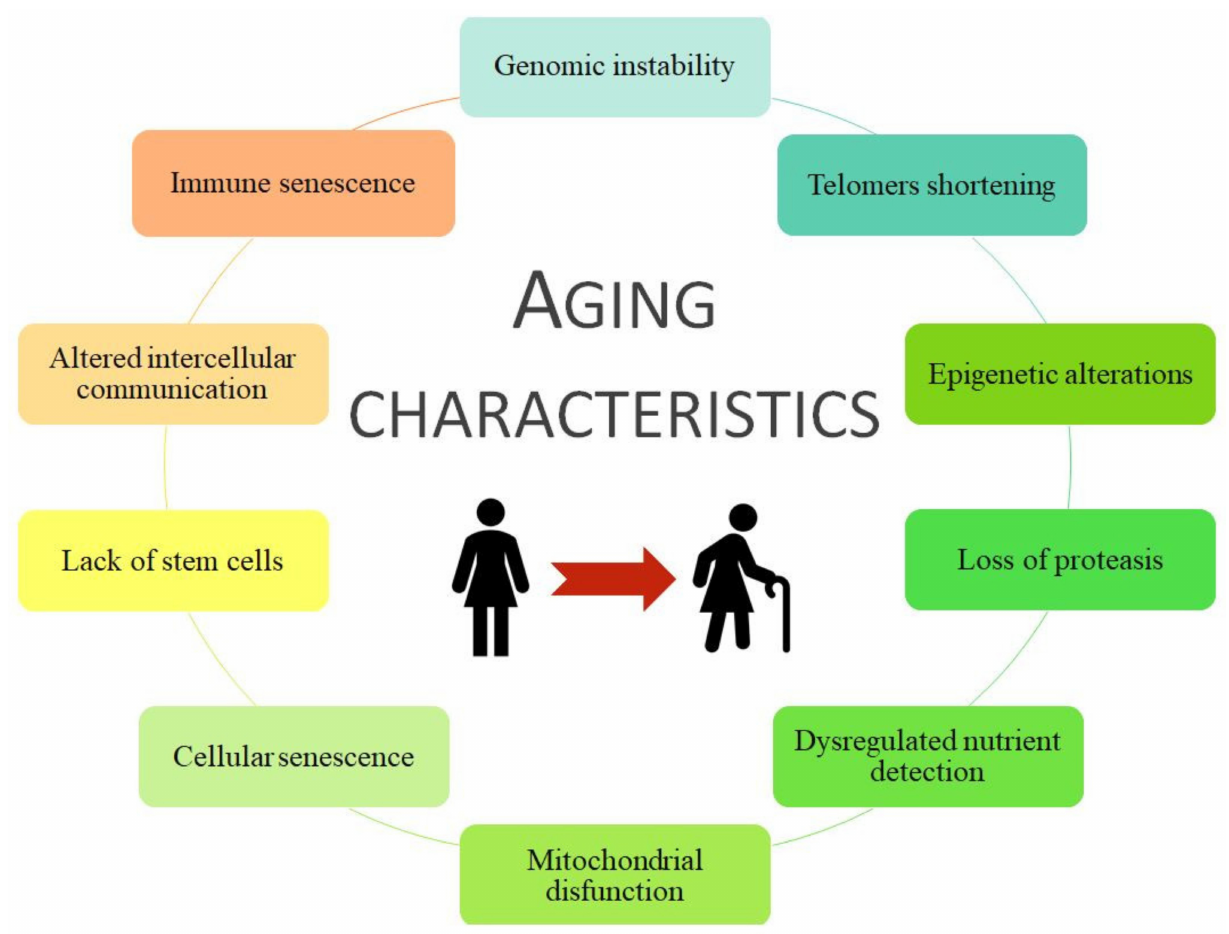
Figure 1. The 10 characteristics of aging. Modified from